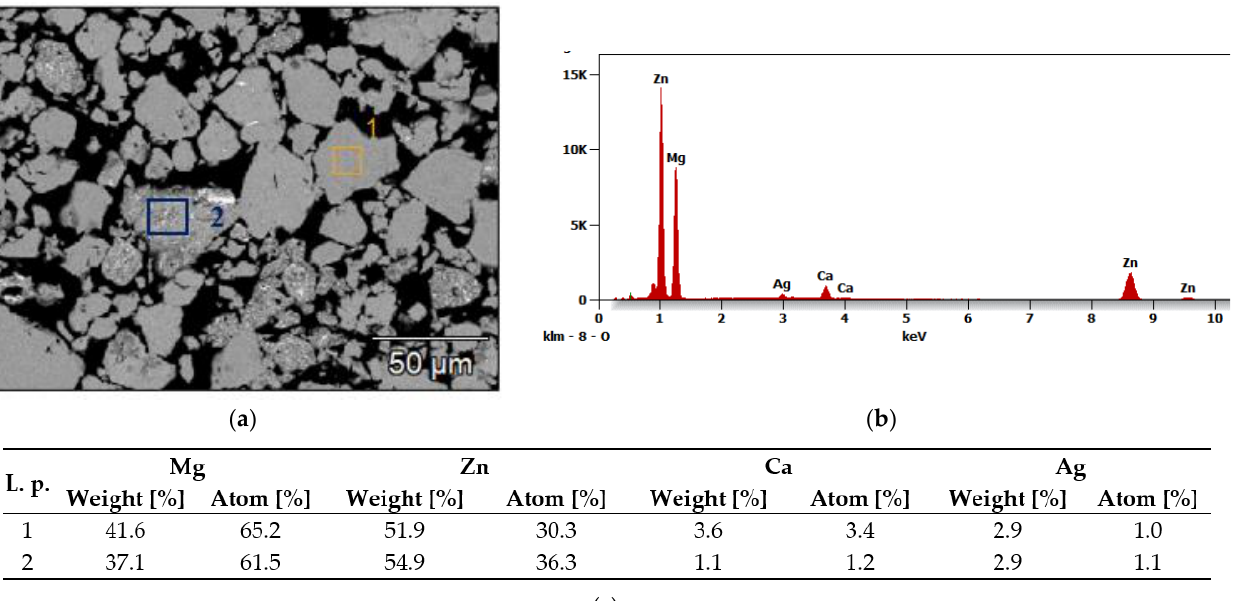
Figure 3. SEM images obtained for Mg 65 Zn 30 Ca 4 Ag 1 alloy after 70 h of milling, with the following magnification: ( a ) 150×; ( b ) 500×; ( c ) 1500×.